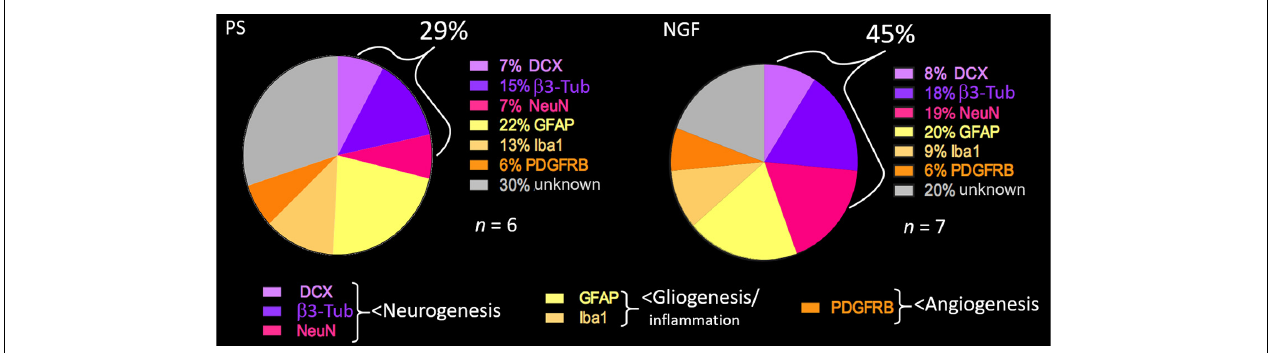
FIGURE 8 | Pie chart showing the percent of cell types detected in the brain sections of PS ( left ) and NGF ( right ) groups identified by histology 12 weeks post-injury. PS group: n = 6; NGF group: n = 7. PS: physiological saline; NGF: nerve growth factor; DCX: doublecortin; NeuN: neuronal nuclei; GFAP: glial fibrillary acidic protein; PDGFRB: platelet-derived growth factor receptor beta; β 3-Tub: beta 3